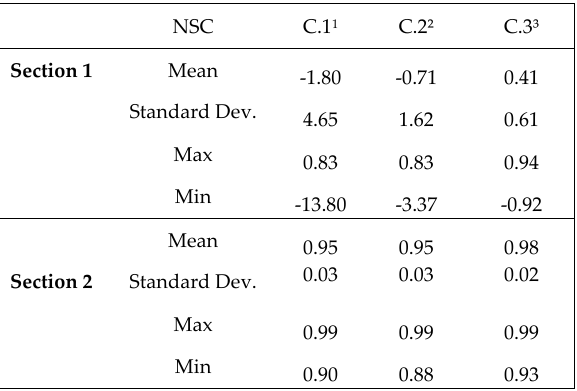
Table 2 Nash-Sutcliffe Coefficients for all approaches using section 1 & 2